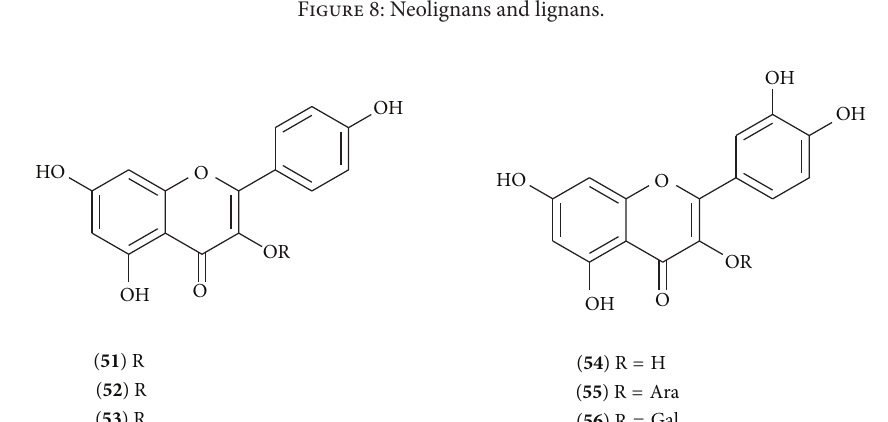
Figure 8: Neolignans and lignans.